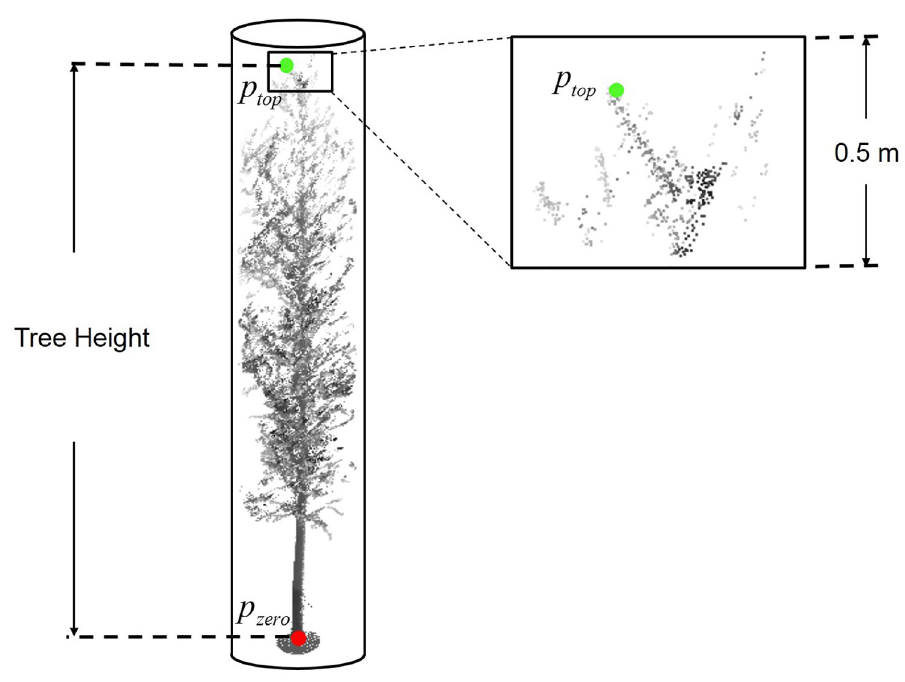
Fig 10. The demonstration of tree height